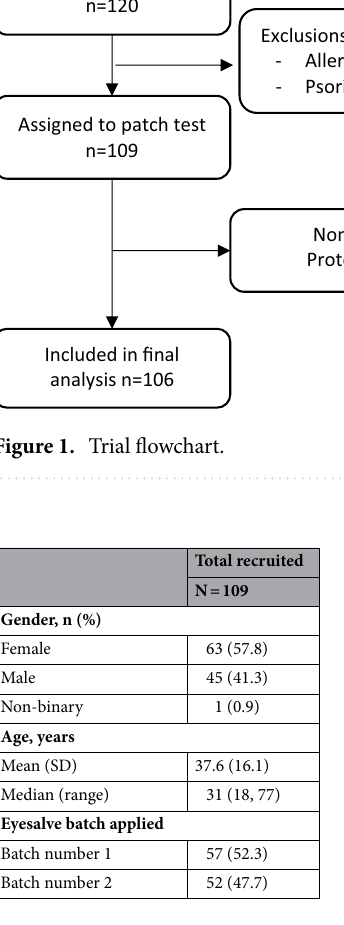
Table 1. Participant